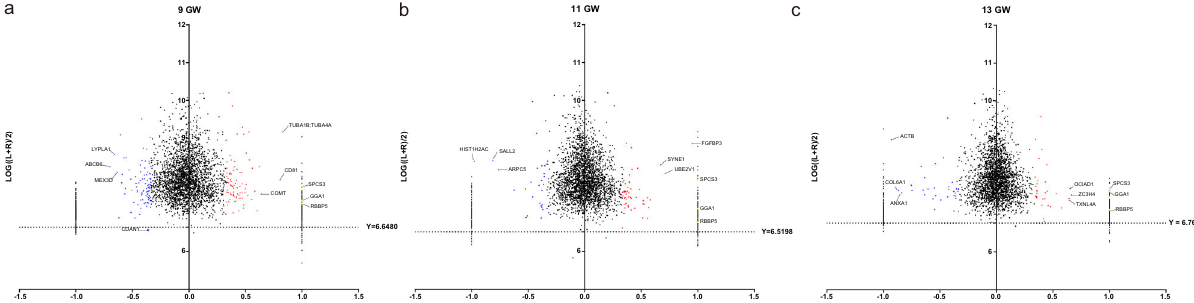
Fig. 4 Proteins detected on only one side of the fetal frontal lobe. a – c Scatter plots showing the average log-normalized LFQ intensity plotted against the asymmetry index ((L − R)/(L + R)) at GWs 9 ( a ), 11 ( b ), and 13 ( c ). Asymmetrically expressed proteins (fold change >2) are represented by red and blue dots. Proteins that showed the three highest levels of asymmetric expression are marked. Three proteins showing unilateral expression at all three GWs are represented by yellow triangles. The horizontal line represents the 1st percentile of the bilaterally averaged intensities of proteins that can be detected. Codanin-1 (CDAN1) is marked due to a lack of suf fi cient intensity. GWs gestational